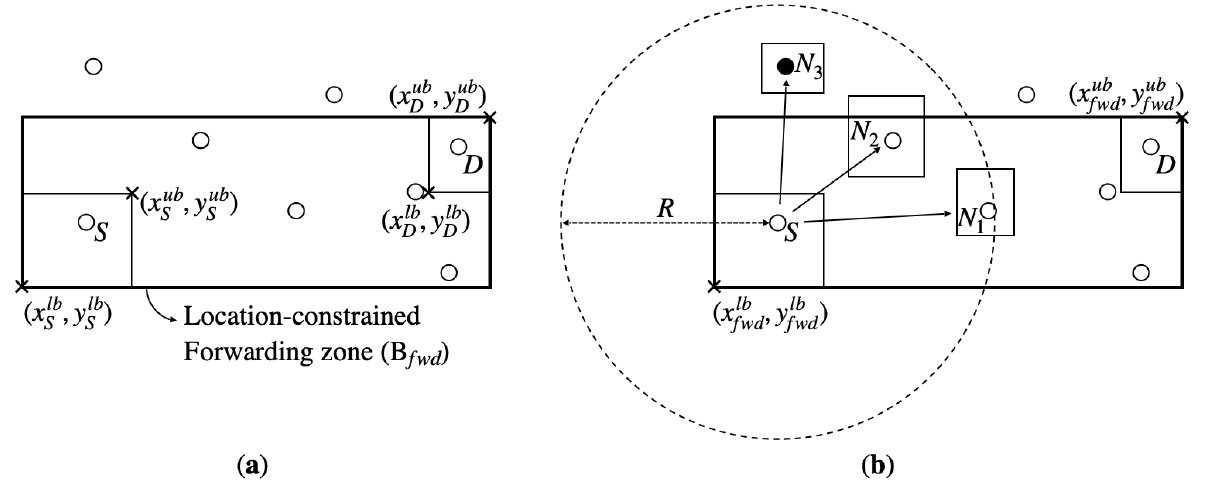
Figure 3. The process of ( a ) Determining the location-constrained forwarding zone and ( b ) location-aided P2P route